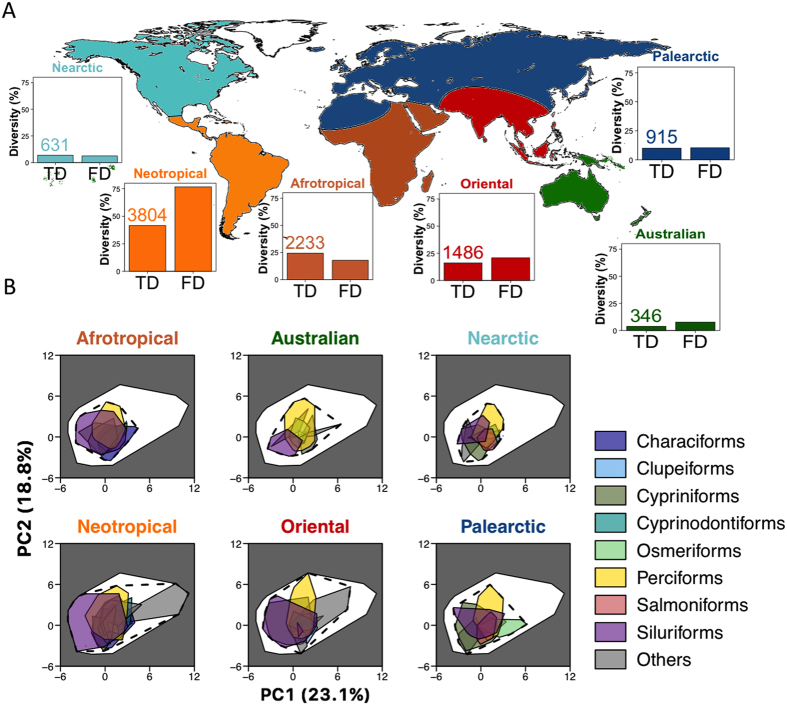
Fish taxonomic and functional diversity in the 6 biogeographic realms.(A) The six realms are displayed on the map. For each realm, the taxonomic (TD) and the functional diversity (FD) are represented as a percentage of the world taxonomic or functional diversity. The number of species in each realm is given above the TD bar. (B) Functional space of the world freshwater fishes is the white area in the 2-dimensions space made by first and second principal component (PC) axes summarizing the 5-dimensions functional space built based on 10 morphological traits (see other projections in Supplementary Fig. S2). The percentage of variance explained by each PC axis is given in brackets (see also Supplementary Figs S2 and S3). Fish functional diversity in each realm is illustrated by the polygon delimited by the black dashed line. The coloured polygons within it show the functional diversity of the most speciose fish orders. The map was generated using ‘maps’ and ‘mapproj’ libraries, available in R 3.0 (http://www.r-project.org).